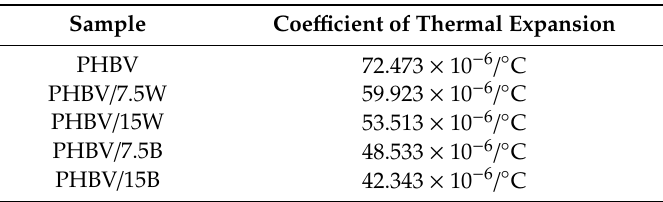
Table 1. Coe ffi cient of thermal